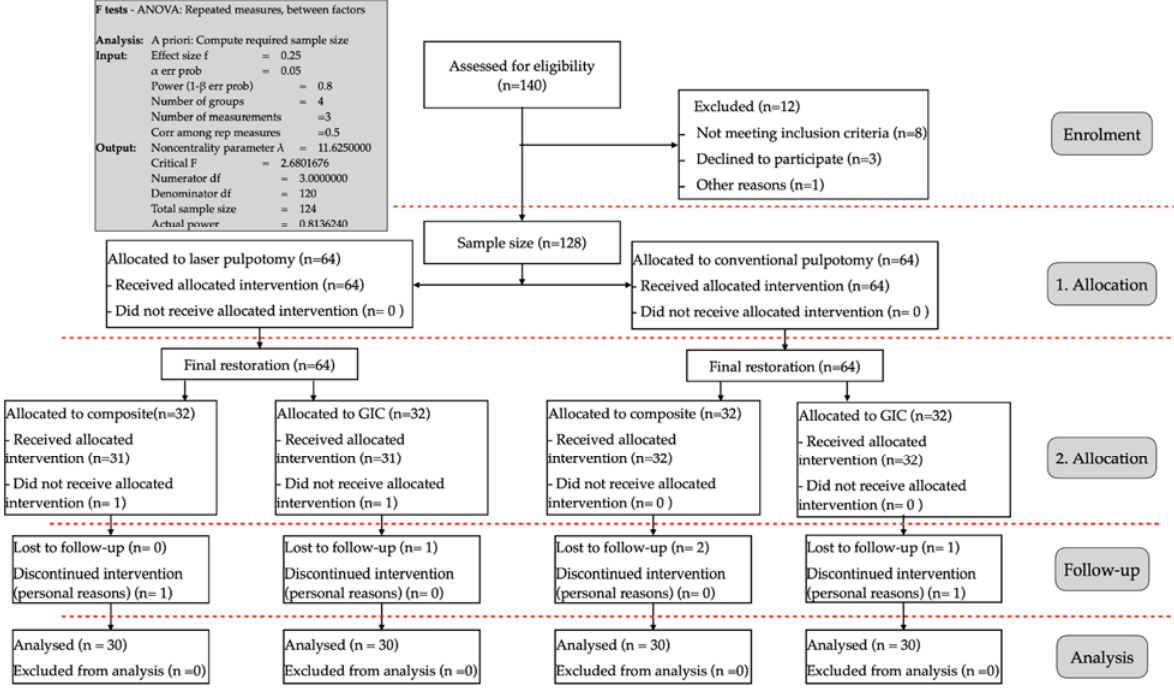
Figure 1. Sample size and the study protocol.